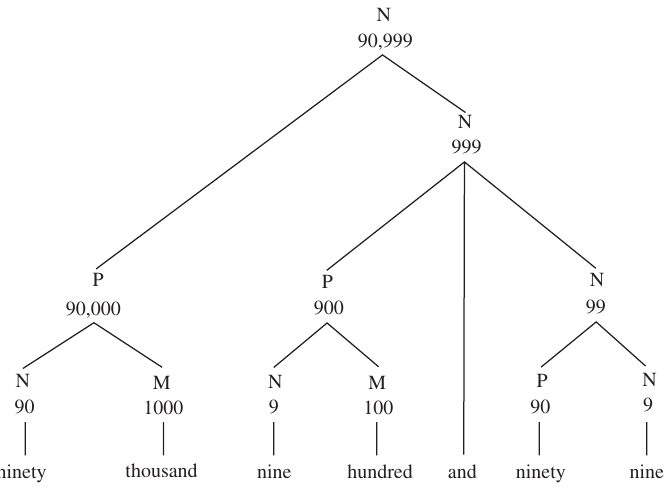
Figure 2: Derivation of English Numeral for Number